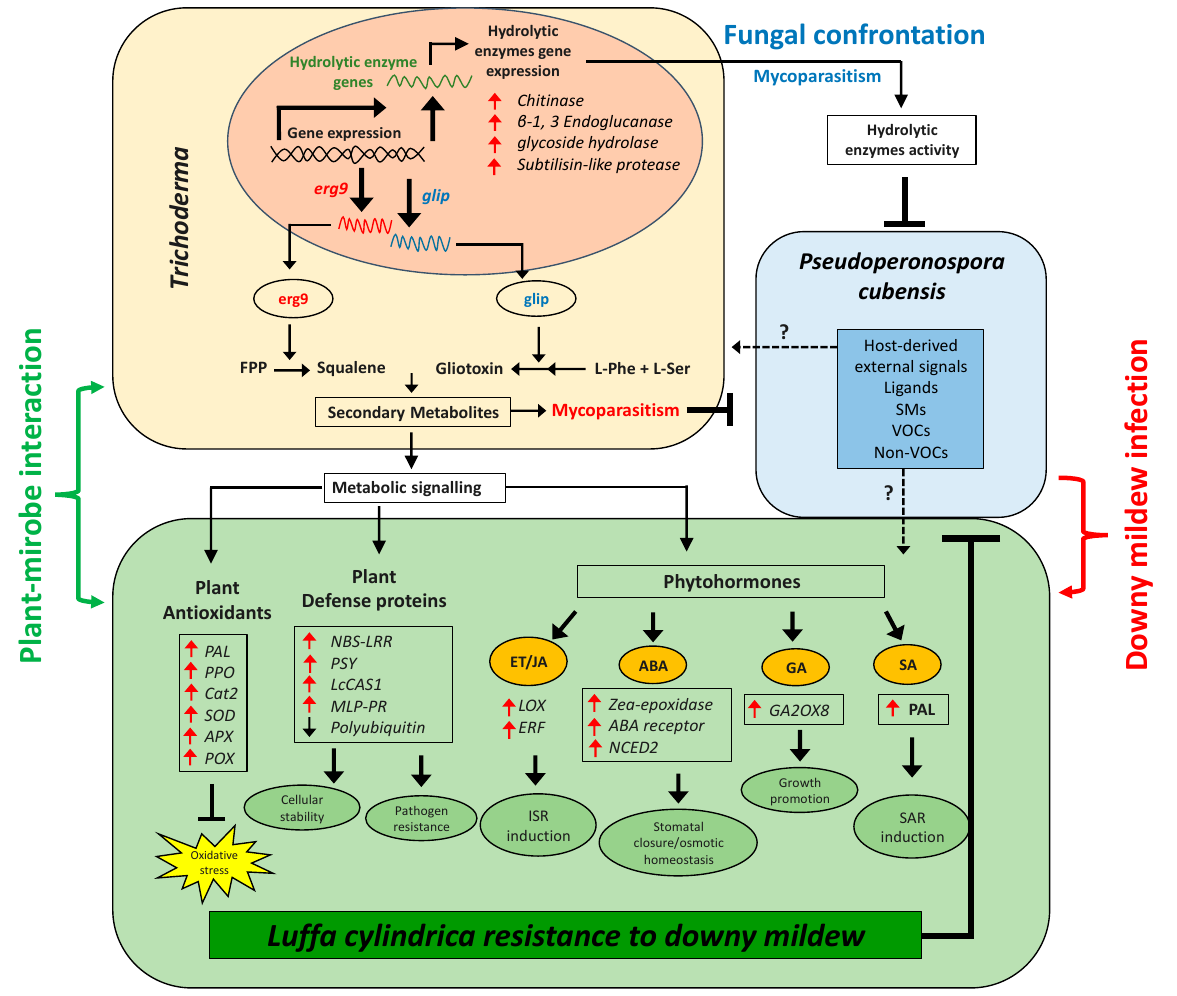
Figure 10. Model of ThM9 and TvA1 action upon P. cubensis infection in luffa.